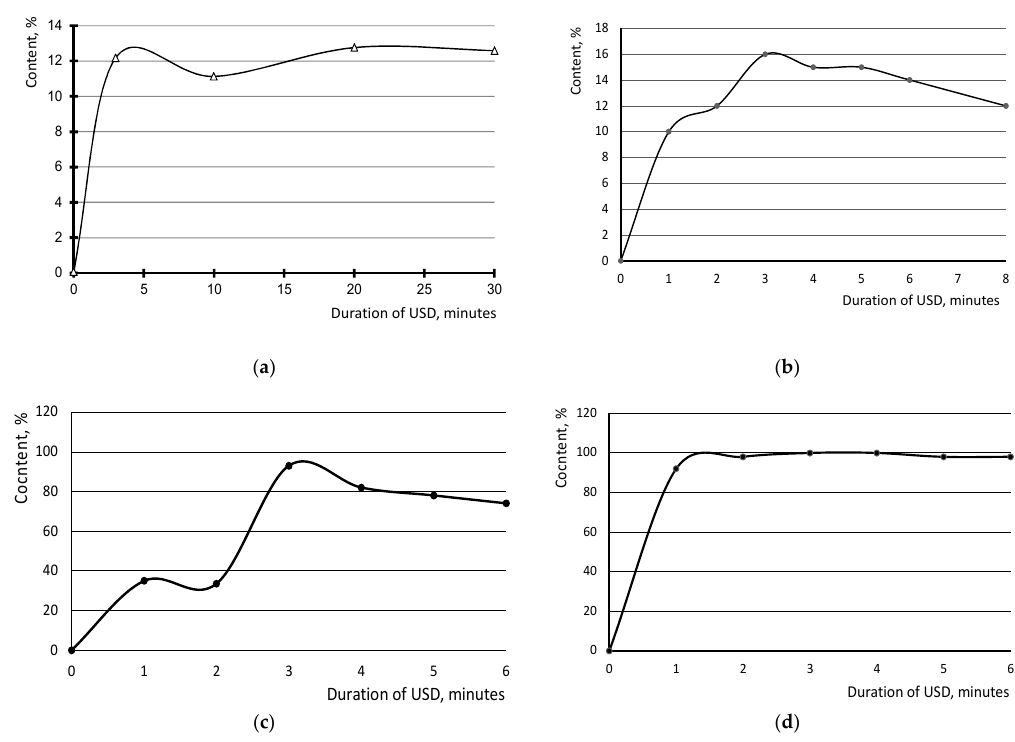
Figure 8. Change in the particle content < 100 nm from the duration of the USD: ( а ) aqueous (MFN and Sulfanol); ( b ) aqueous (CNPLUS and ViscoCrete 2100); ( с ) organic (MWCNT and industrial oil); ( d ) organic (MWCNT-MD and RSPE).